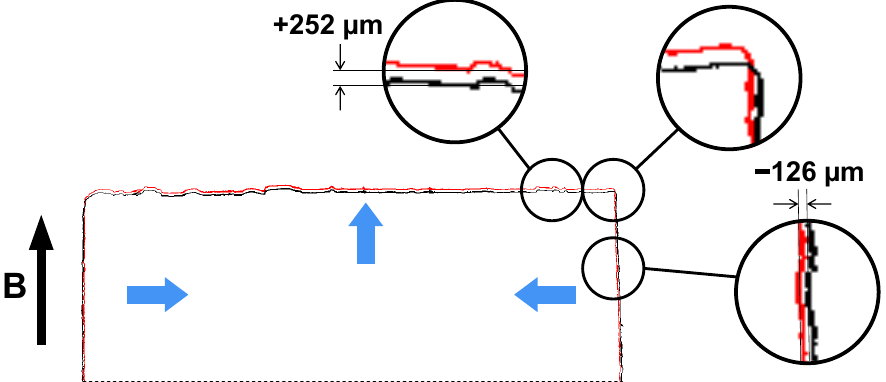
Figure 6. Contour of the sample bM36. Black is the contour at B = 0 mT, and red is the contour at B = 510 mT. The thick arrows indicate the directions of the field-induced